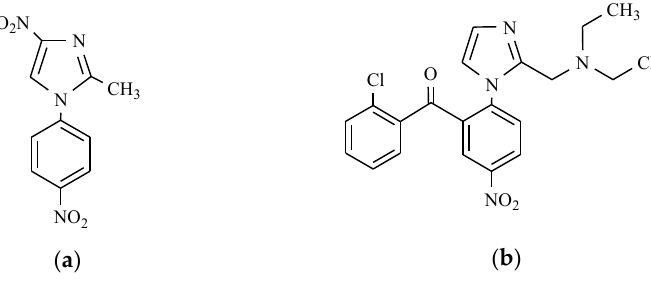
Figure 24. The 4-nitroimidazole derivatives as nootropic: ( a ) Nitrefazole; and ( b ) Nizofenone.